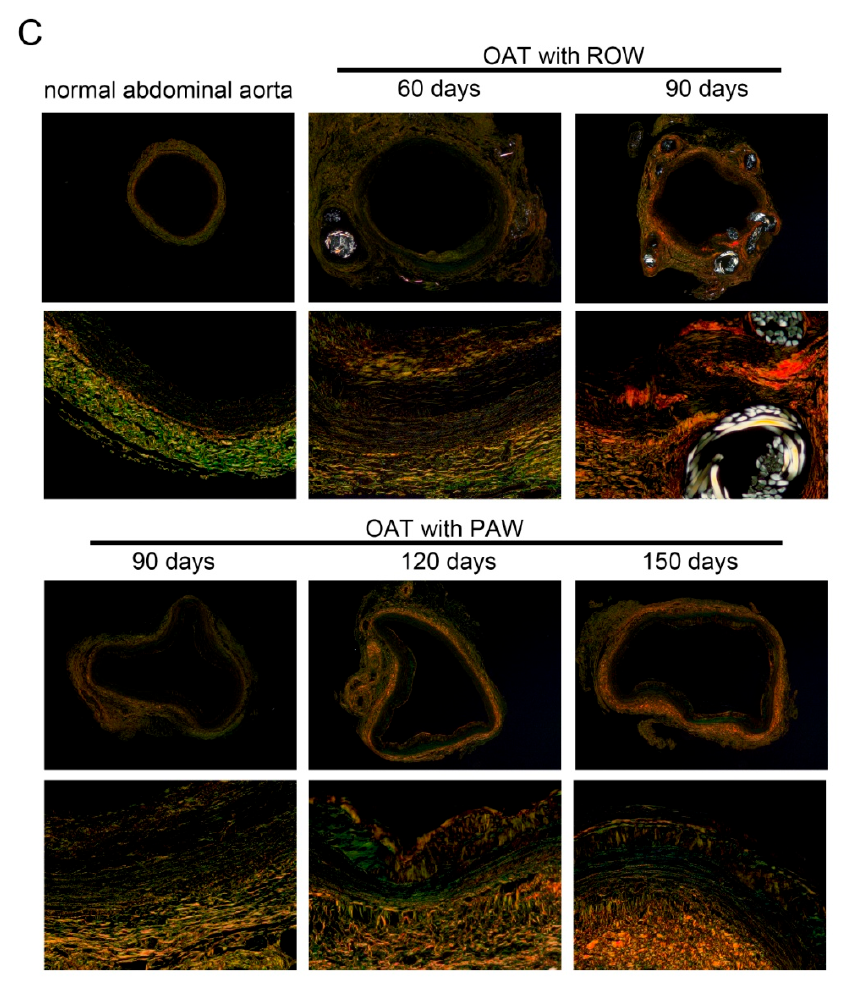
Figure 1. Administration of PAW in OAT ACI/NKyo rats resulted in reduced allograft vasculopathy. ( A ) Representative photographs of vasculopathy in thoracic aortas (from donor PVG/Seac rats) stained with H&E. The arrowheads indicate calcified lesions, and arrows indicate internal elastic lamina. ( B ) The graphs represent the ratio of intimal and vessel wall areas in the aortas from the five experimental groups. The images are 40× magnified. The results are expressed as the mean ± SD. Statistical evaluations were performed using the Student t -test, followed by Dunnett’s test. * p < 0.05 was considered as significant. ( C ) Histopathological features of thoracic aorta cross-sections were observed using Picro sirius red staining. The slides were observed via polarized light microscopy (40× (upper) and 200× (lower) magnification).